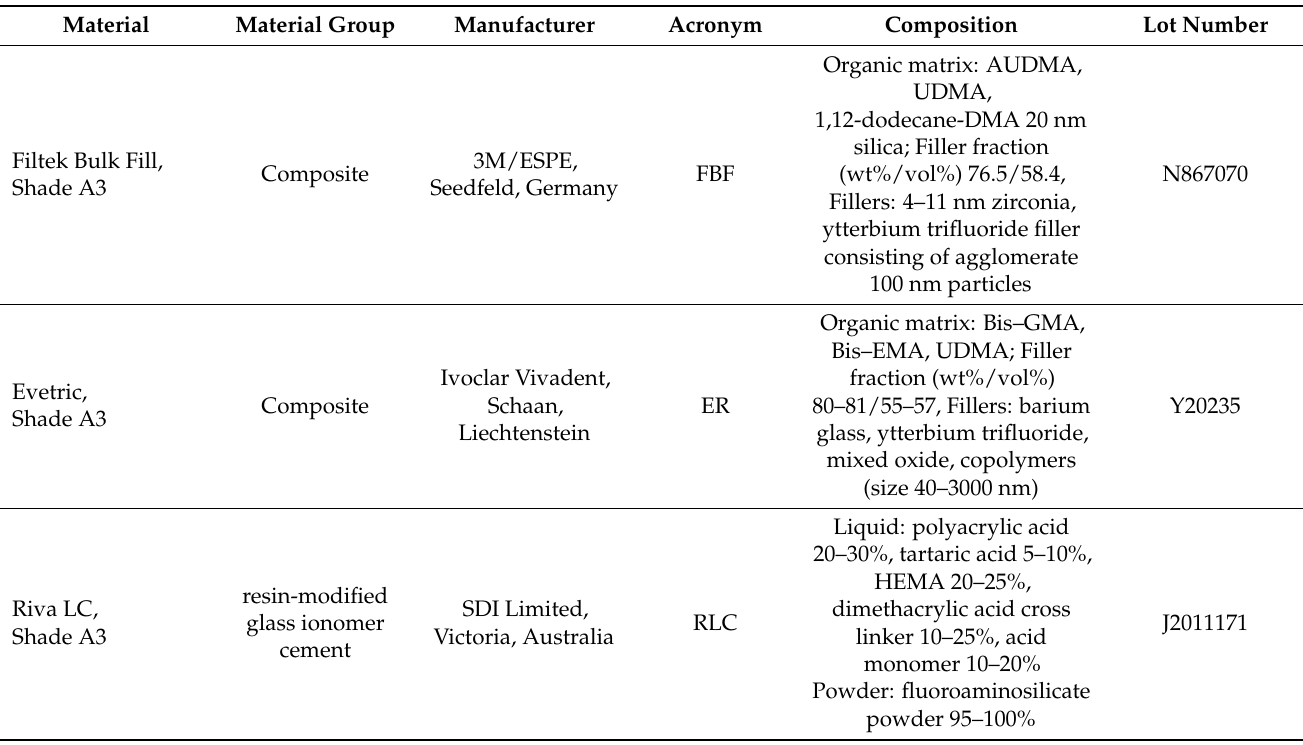
Table 1. Detailed characteristics of the dental restorative materials used in the